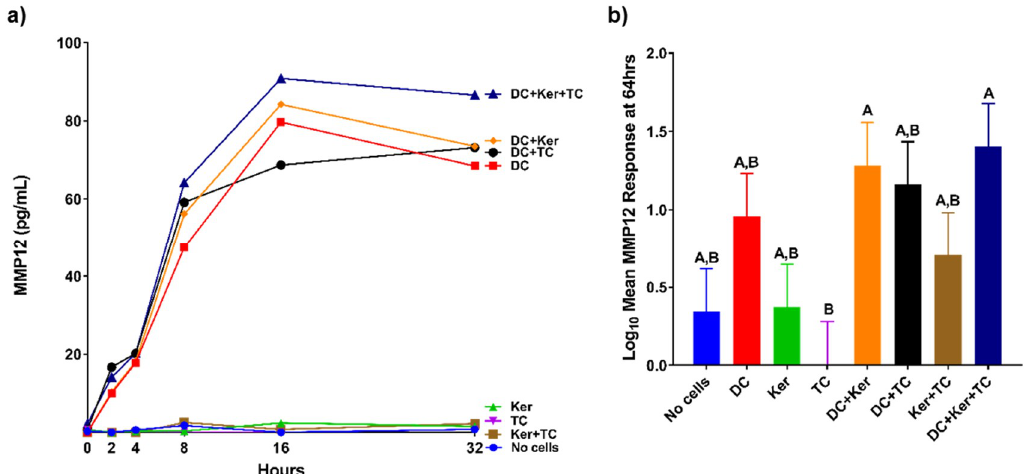
Figure 5. ( a ) MMP12 responses of single cell and co-cultures when treated with HagB ( n = 3). HagB was added at Time 0 to single-cell cultures and co-cultures of T-cells (TC), GE keratinocytes (Ker), and dendritic cells (DC). MMP12 concentrations were determined at 0, 2, 4, 8, 16, and 32 h. The MMP12 responses from the HagB diluent were subtracted from the HagB-induced MMP12 responses. ( b ) MMP12 responses to HagB at 64 h ( n = 9). The MMP12 responses from the HagB diluent were subtracted from the HagB-induced MMP12 responses. A two-way fixed effect ANOVA was fit to log-transformed concentrations of MMP12. Pairwise group comparisons were conducted using the post-hoc Tukey’s honest significance test. A 0.05 level was used determine statistically significant differences between groups. Shared letters above bars indicate the groups are not statistically different from one another ( p > 0.05), while differing letters indicate significantly different mean values ( p < 0.05).